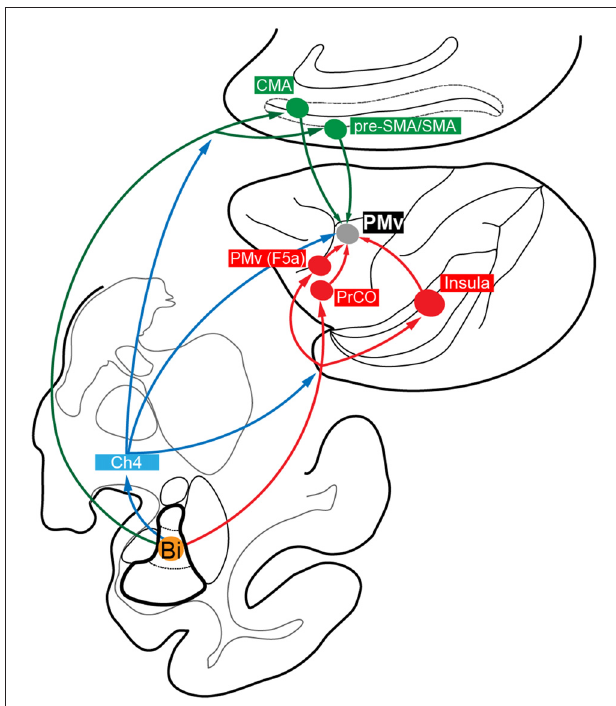
FIGURE 6 | Summary diagram showing the proposed multisynaptic pathways from the amygdala, especially from Bi, to PMv: disynaptic pathways mediated by the medial cortical areas (Bi → CMA/pre-SMA/SMA → PMv; green); disynaptic pathways mediated by the lateral cortical areas (Bi → PrCO/Insula/PMv (F5a) → PMv; red); disynaptic and trisynaptic pathways mediated by Ch4 in the basal forebrain and, then, by the medial and lateral cortical areas